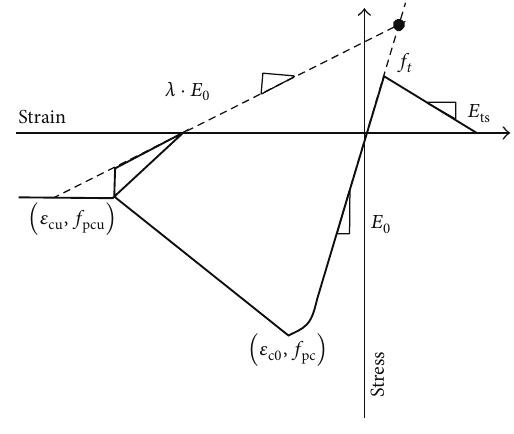
Figure 18: Stress-strain relationship of concrete.